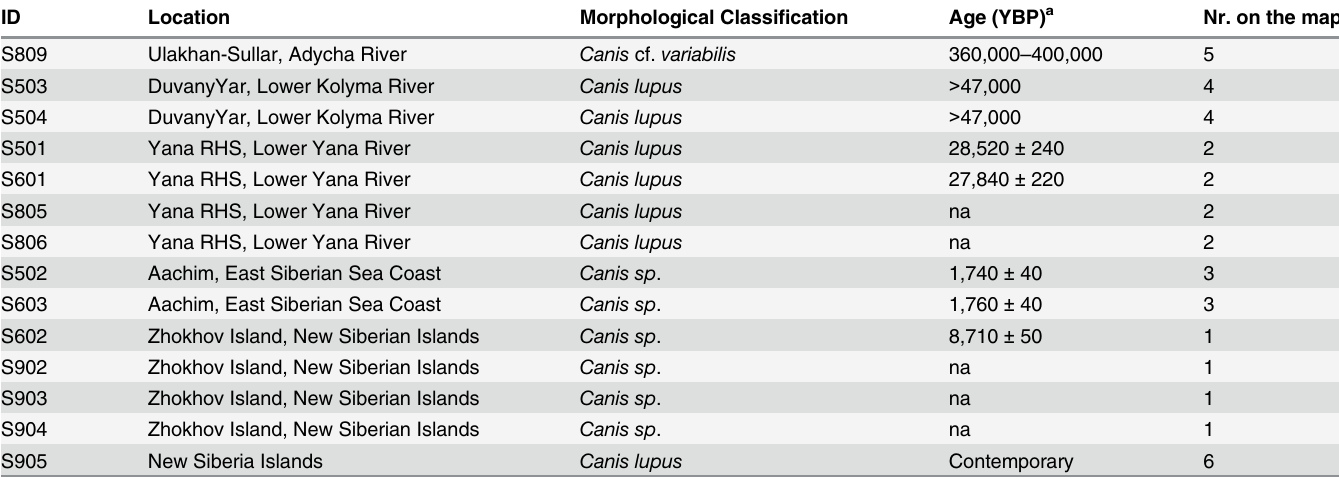
Table 1. Description of the canid specimens analyzed in this